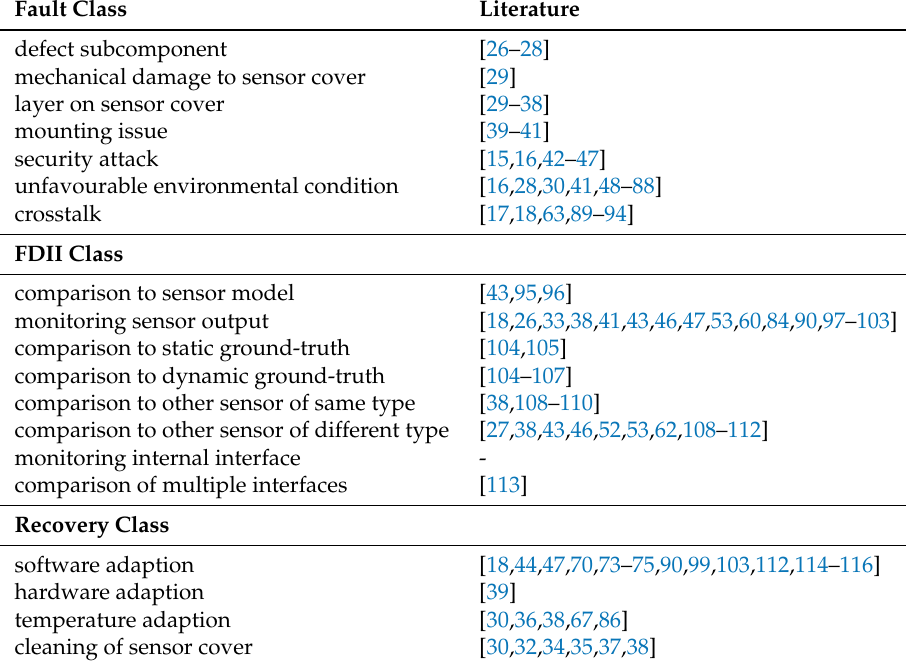
Table 4. Literature review of fault classes, FDII and recovery methods for automotive